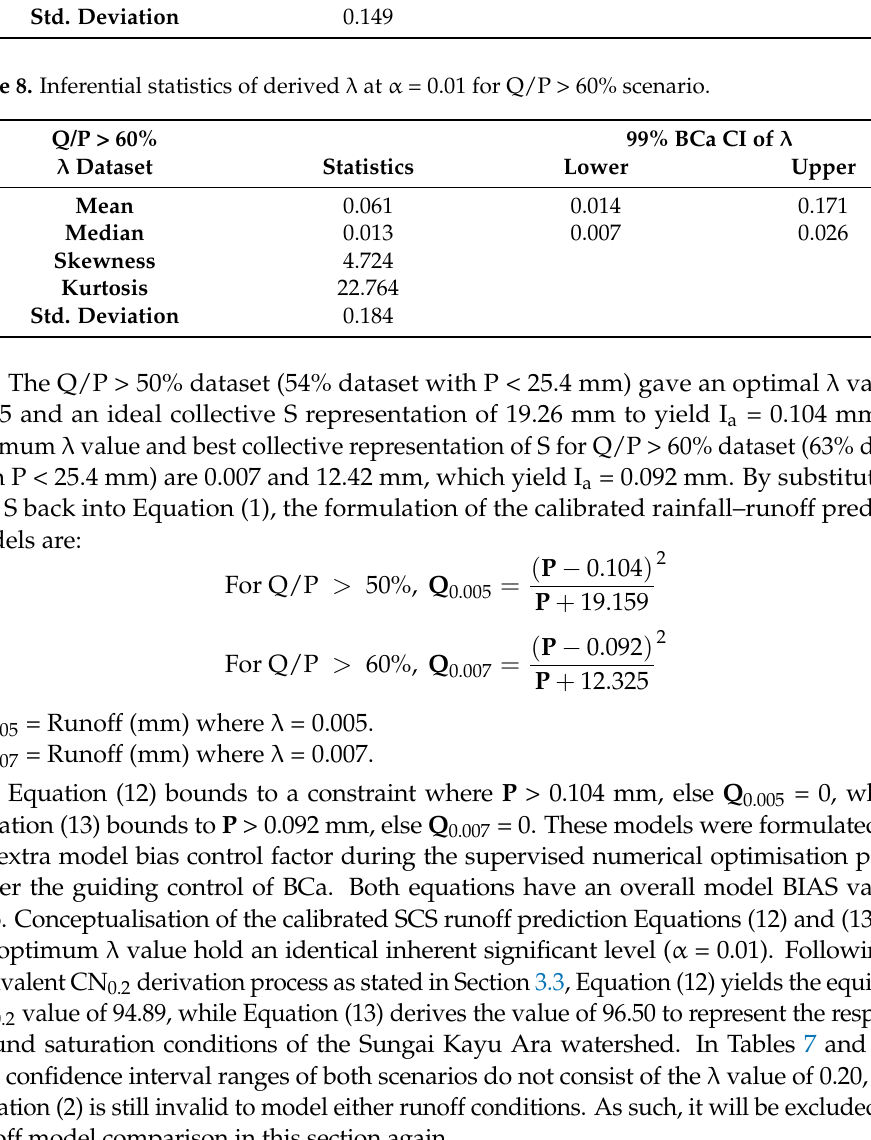
Table 7. Inferential statistics of derived λ at α = 0.01 for Q/P > 50% scenario. Q/P > 50% 99% BCa CI of λ λ Dataset Statistics Lower Upper Mean 0.043